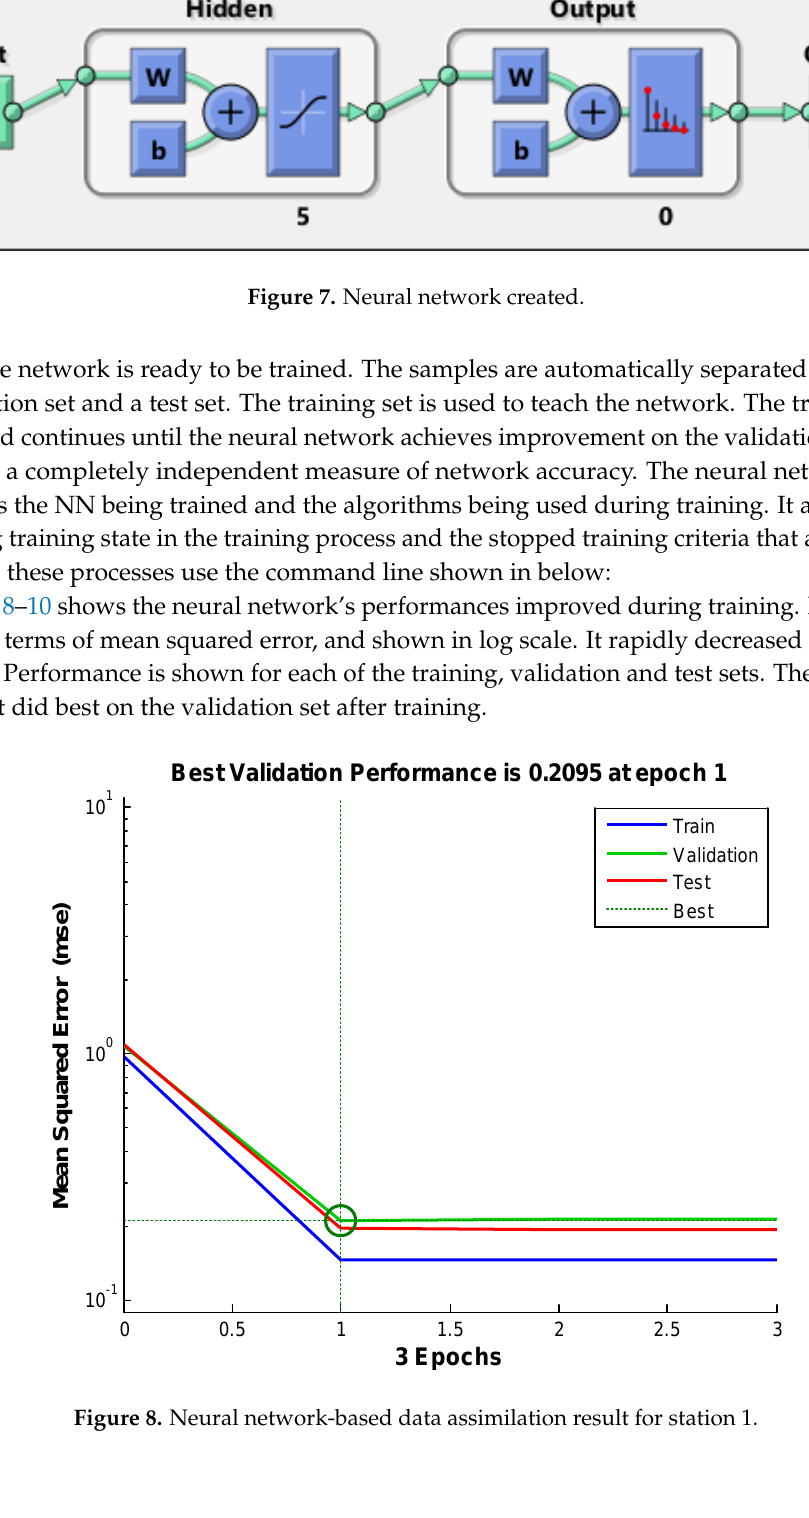
Figure 8. Neural network-based data assimilation result for station 1.